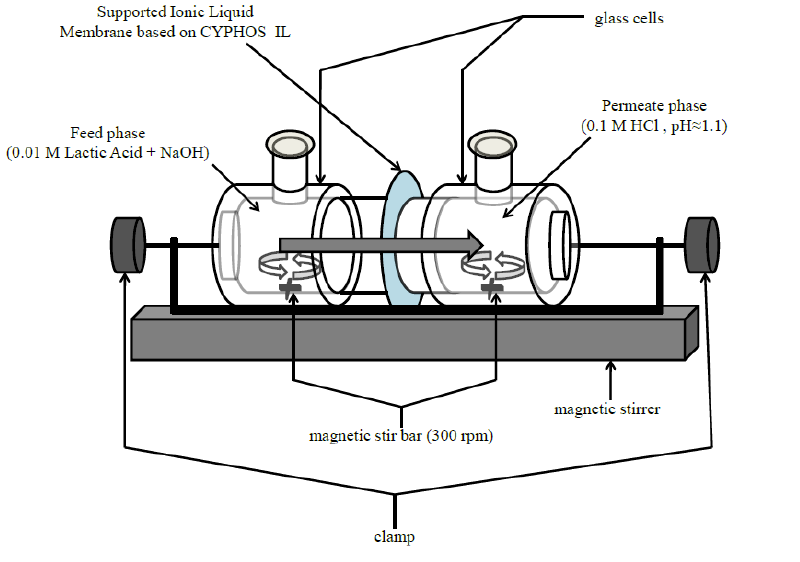
Figure 1. Schematic diagram of the experimental setup for the permeation